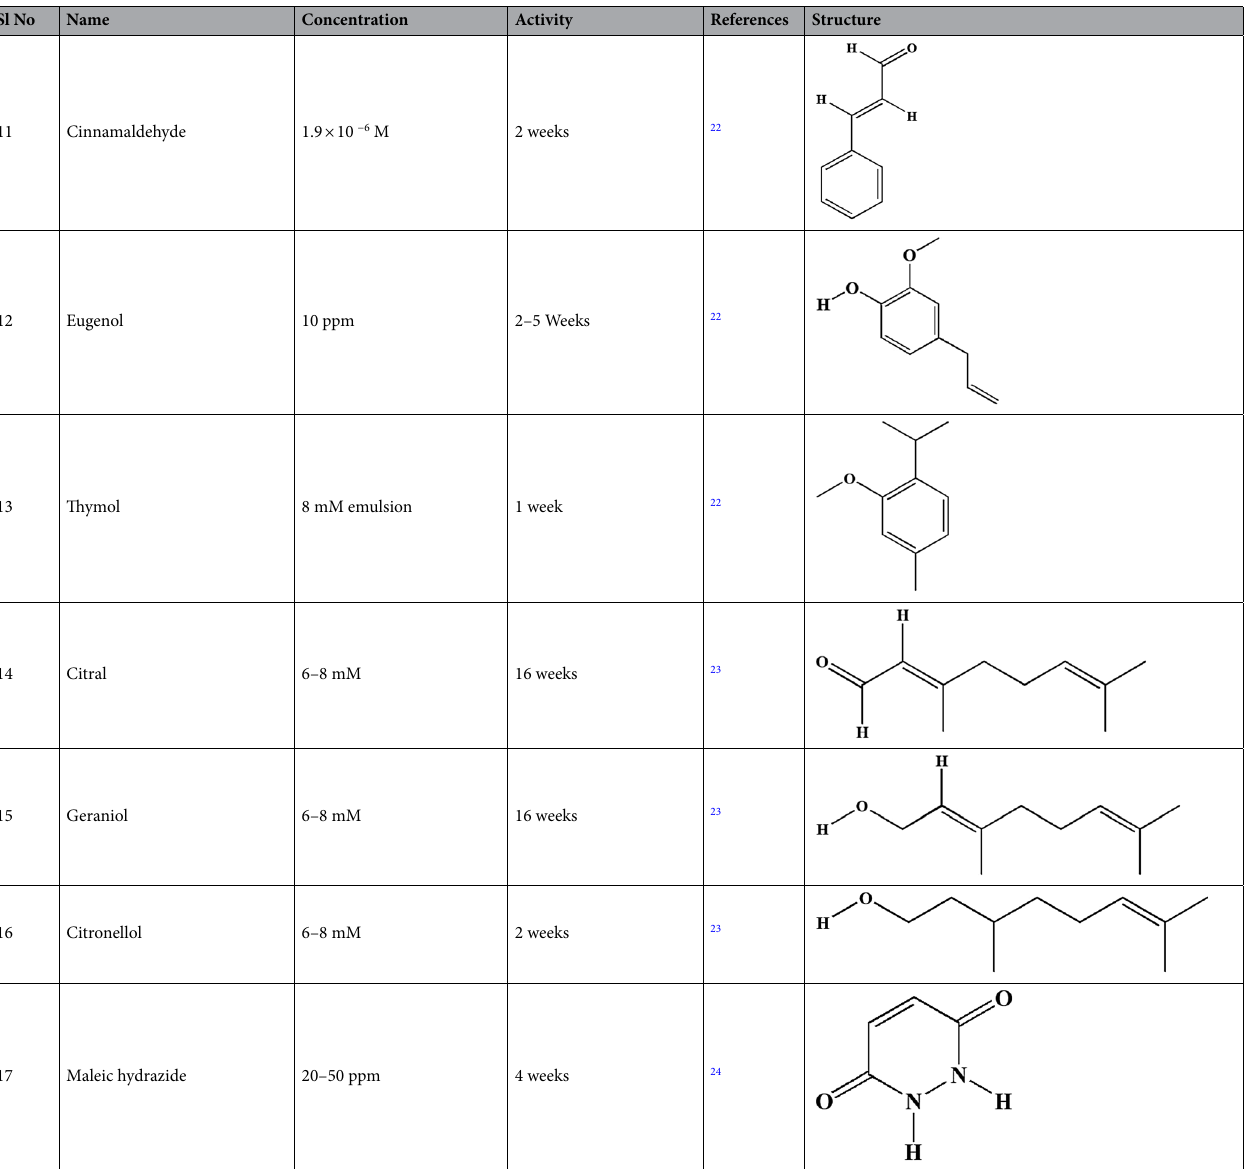
Table 1. List of reported compounds used for sprout suppression of potato tubers and their respective